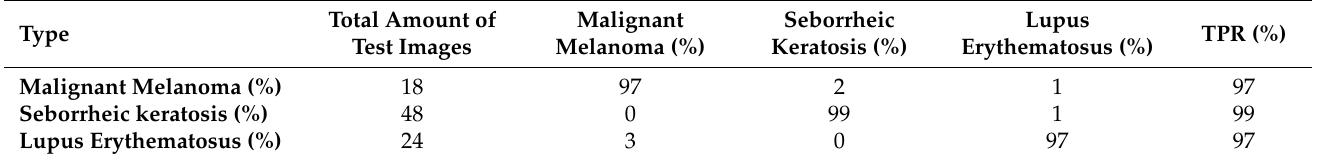
Table 8. DermIS dataset confusion matrix.